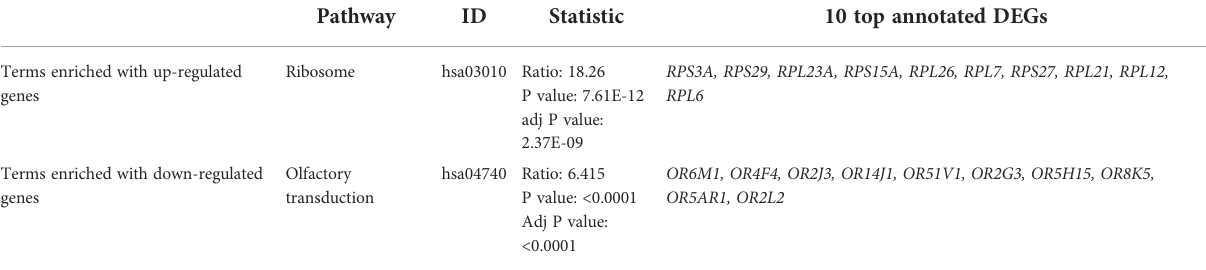
TABLE 4 Pathway analysis enrichment results on KEGG.